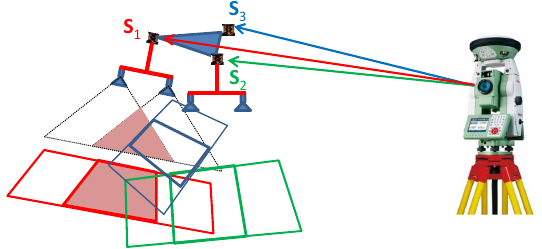
Figure 4: Scanning of larger areas requires to move the scanner around. Successive stereo pairs are captured, and prism positions S j , j = 1 . . . n are recorded. This figure also shows the overall “footprint” per scan, i.e. a mapping of the two respective images to the